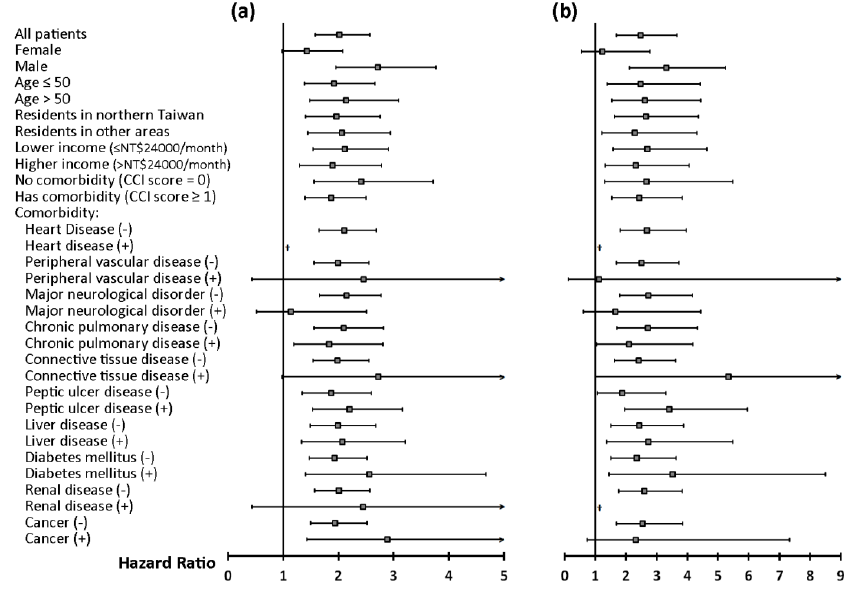
Figure 3. Stratified analyses of multivariable Cox analyses. ( a ) Study arm A (suspected SA vs. control A); ( b ) Study arm B (probable SA vs. control B). Adjusted hazard ratios (95% confidence intervals) of sleep apnea, adjusted for sex, age, residency, income level, and the presence of various comorbidities (except for the stratifying variable) are presented. † Hazard ratio cannot be estimated because of small sample size. Abbreviations: SA = sleep apnea; CCI = Charlson Comorbidity Index.